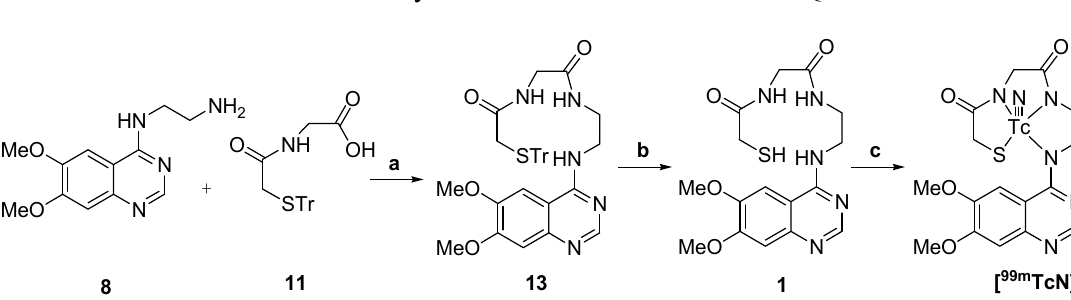
Scheme 3. Synthesis of 99m TcN-MAG-ADMQ.